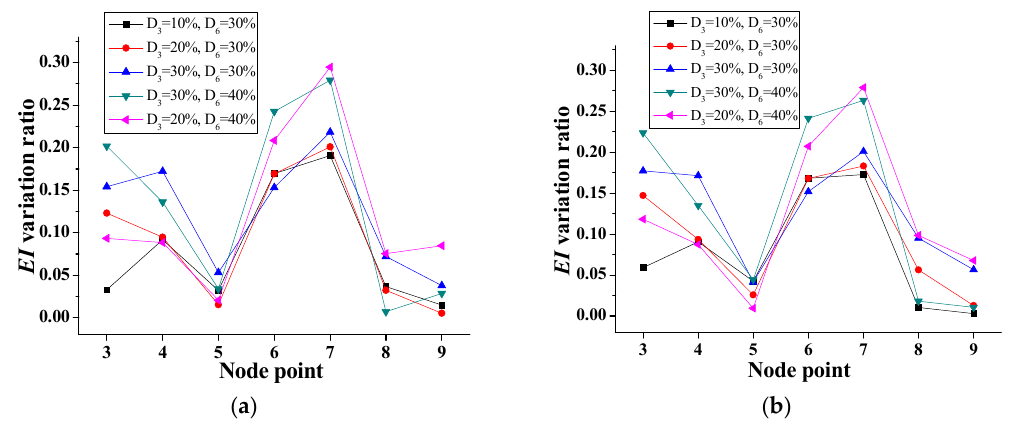
Figure 12. EI variation ratio for double interior damages (Scenario 2). ( a ) Ratio of calculated to undamaged EI . ( b ) Ratio of specified to undamaged EI .